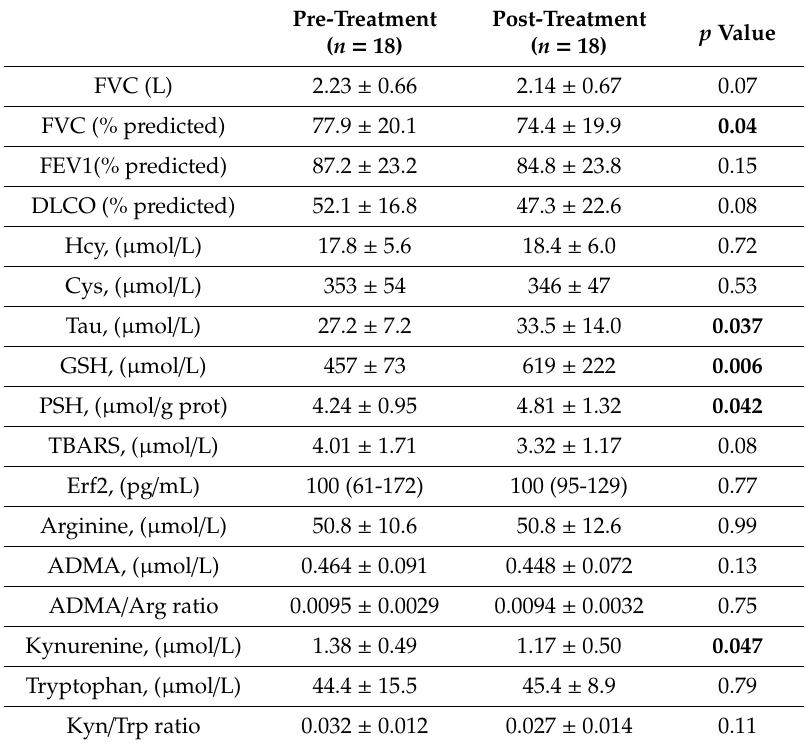
Table 2. Clinical and laboratory characteristics of IPF patients pre- and post-